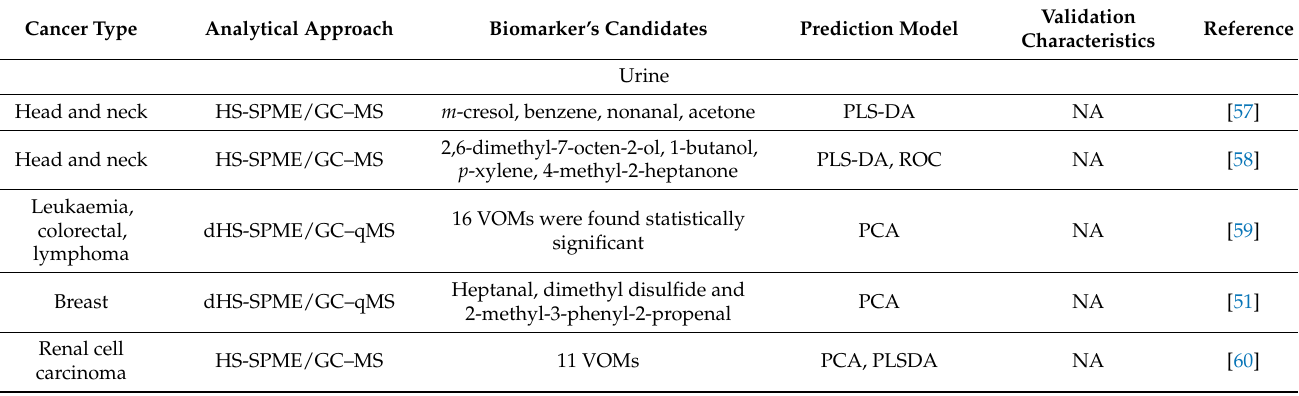
Table 2. Studies on volatile organic compounds for the identification of cancer biomarkers in non- invasive